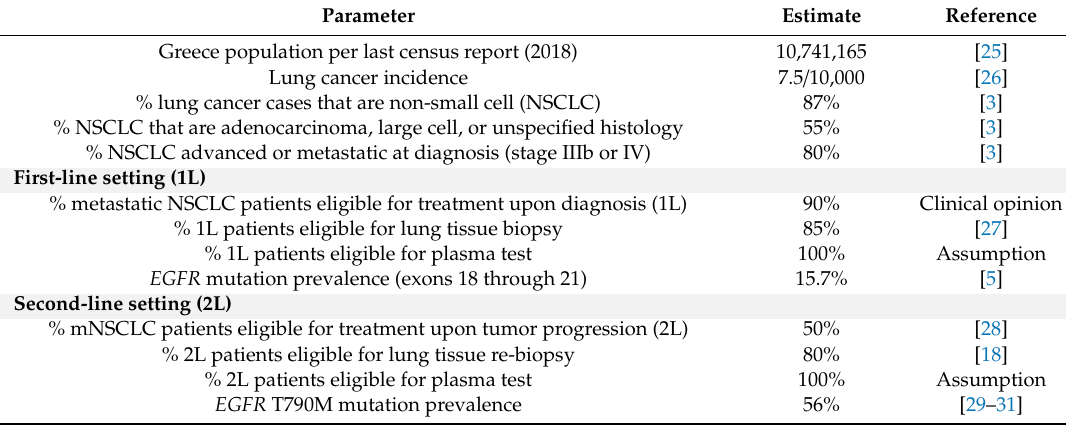
Table 1. Epidemiological estimates used to project eligible diagnostic test